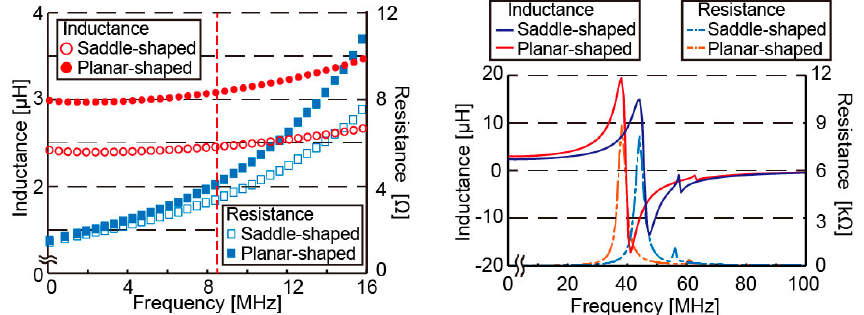
Figure 5. Characteristics of the micro saddle coil. The resistance and inductance of the coils is plotted from 1 to 16 MHz ( left ) and from 1 to 100 MHz ( right ). Table 1. Electrical characteristics of the coil at 8.5 MHz.